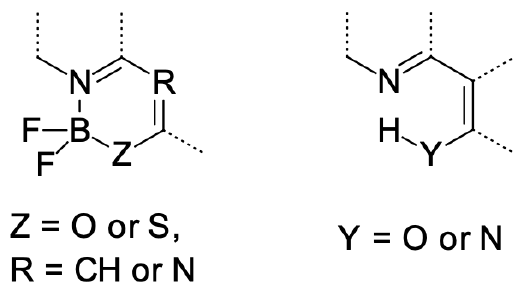
Figure 1. Structural motifs of difluoroboranes ( left ) and hydroxyimidazopiridine ( right )